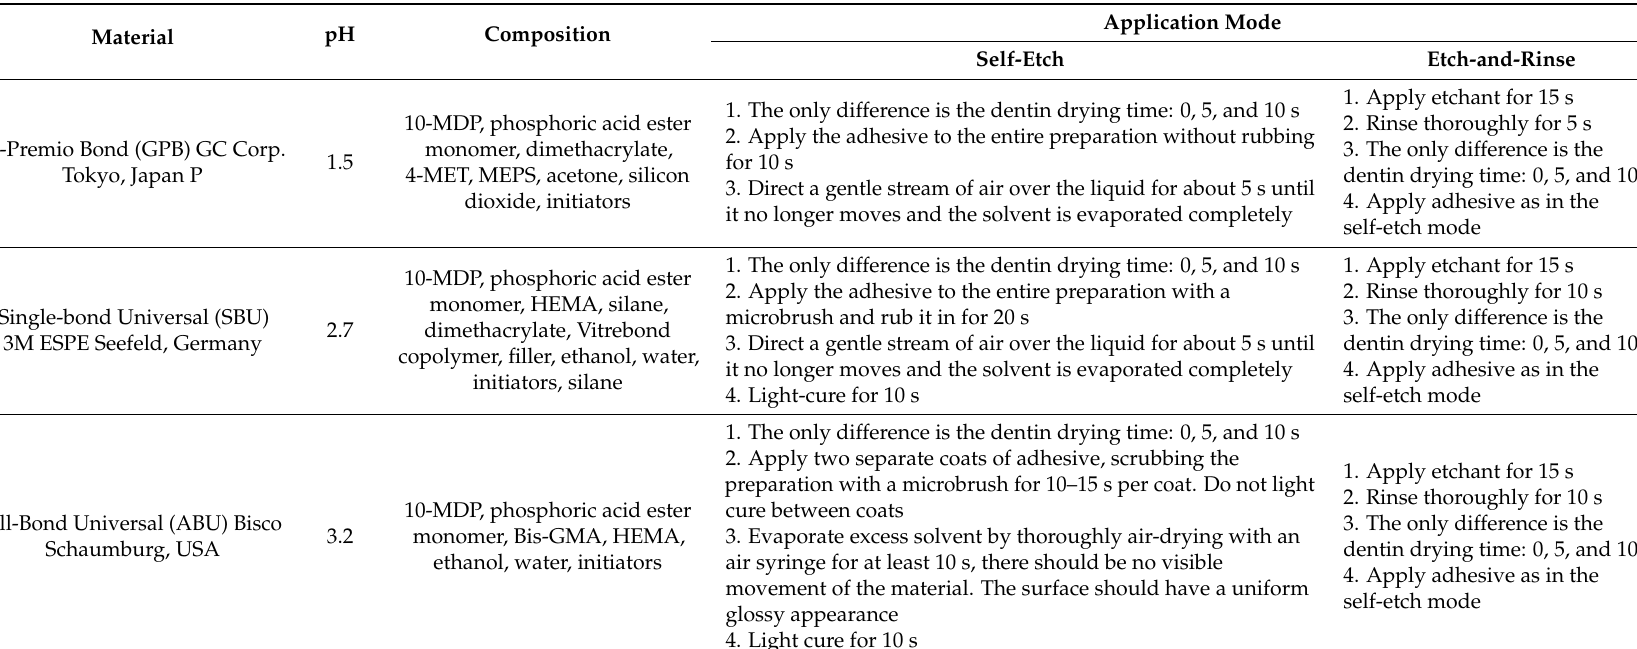
Table 2. Adhesive composition and application procedure (information supplied in the safety data sheets and material